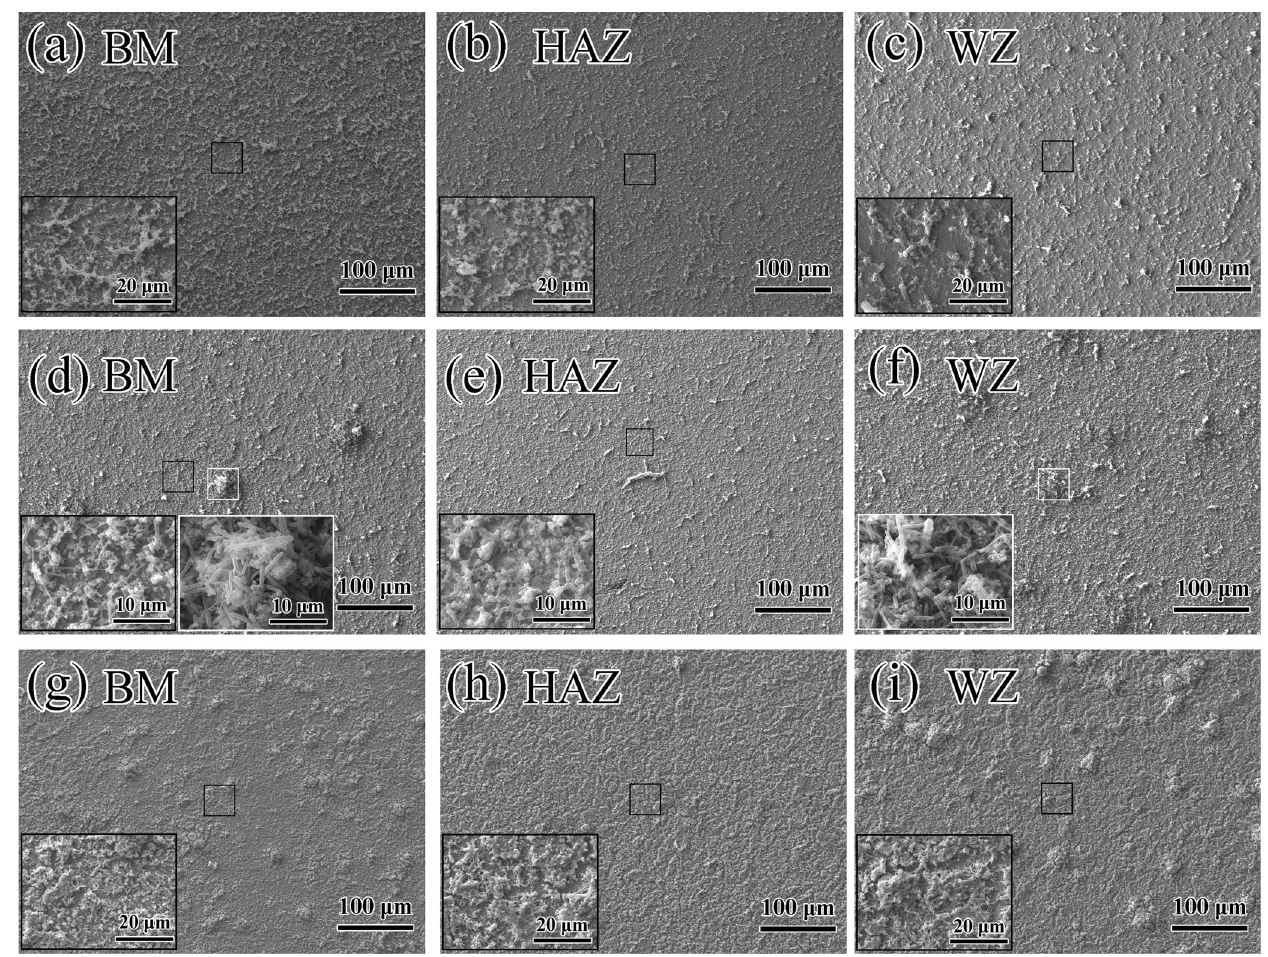
Fig. 1 Bio fi lm on the surface of the welded joint. a – c Show bio fi lm morphology on different zones after 3 d pre-incubation. d – f Show bio fi lm morphology on different zones after 7 d pre-incubation. g – i Show bio fi lm morphology on different zones after 14 d